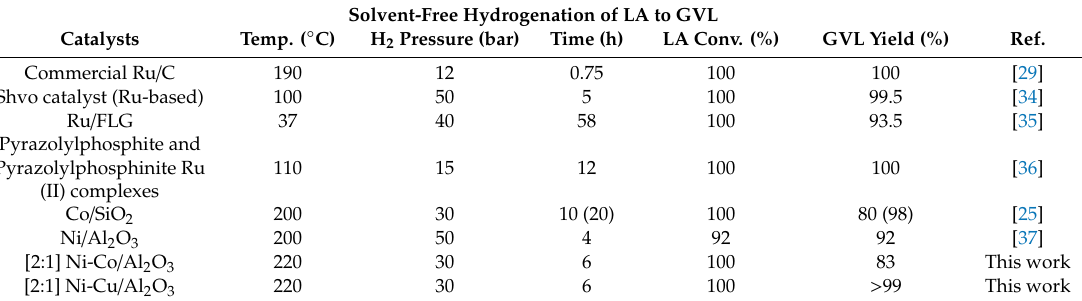
Table 2. Comparison table with the existing catalytic